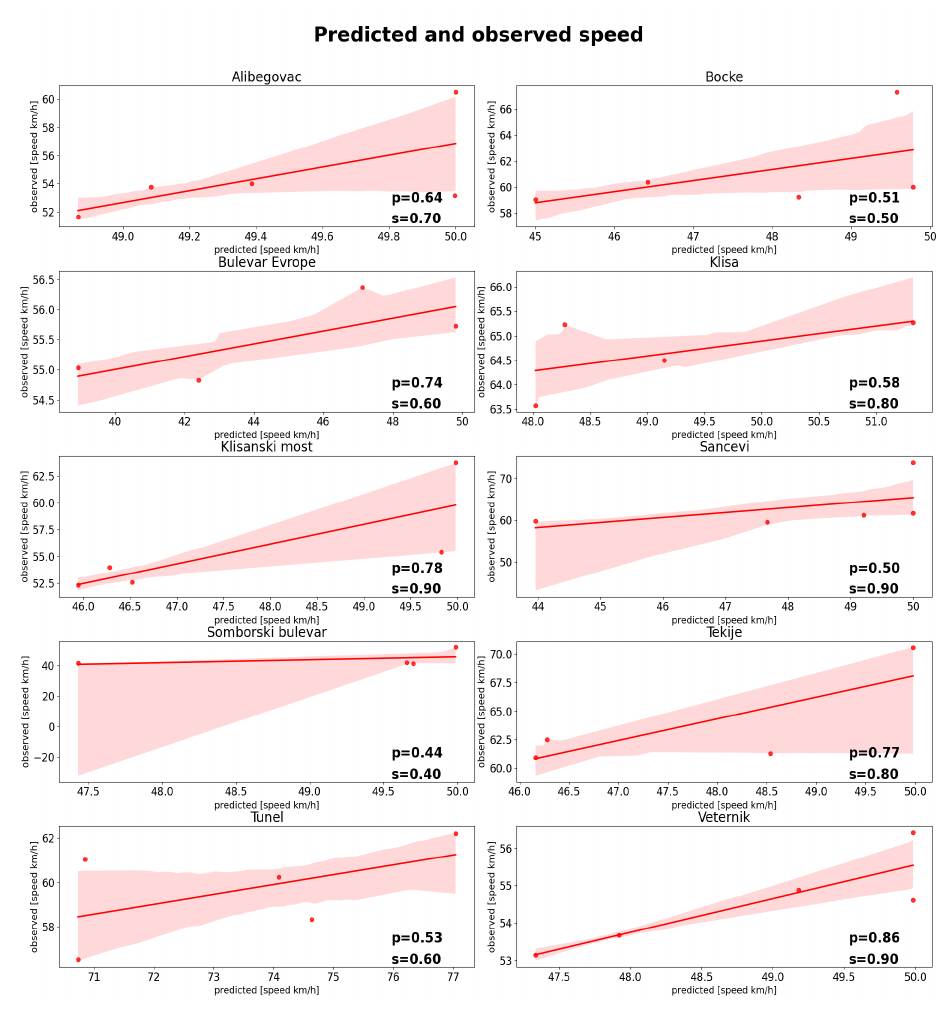
Figure A2. Calibration—Pearson (p) and Spearman (s) correlation coefficients between predicted and observed speed in automatic vehicle counters data set. The selected day from automatic vehicle counters data set was 6 November 2019. Please note: the axes are not in the same scale to emphasize the captured